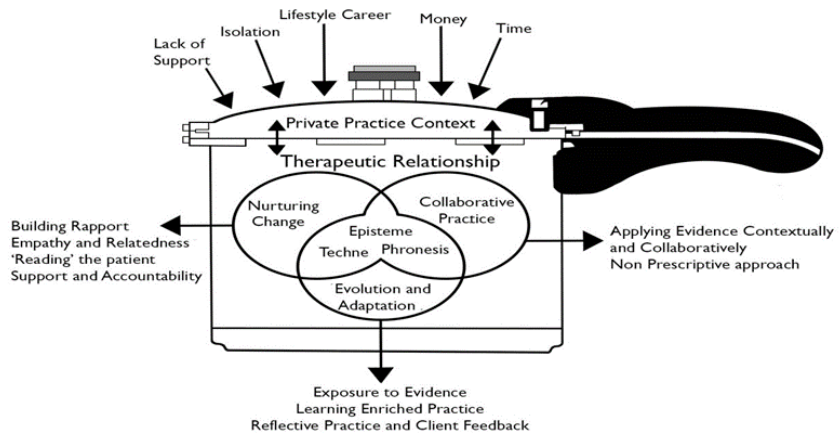
Figure 1. Philosophies Underpinning Dietetic Private Practice.